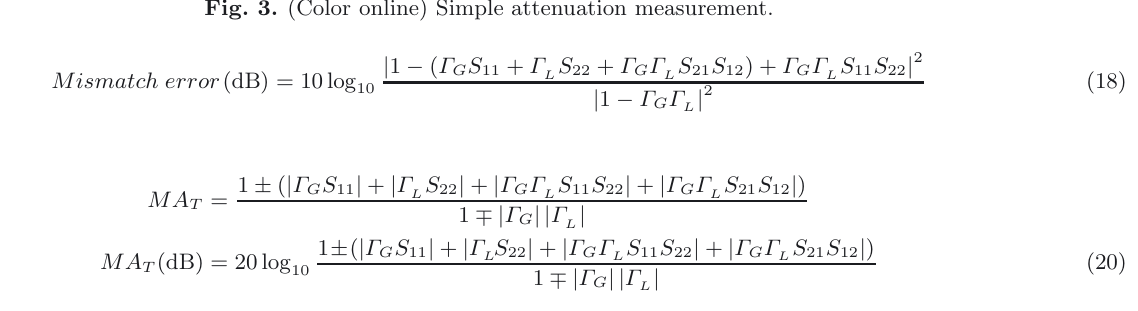
Fig. 3. (Color online) Simple attenuation